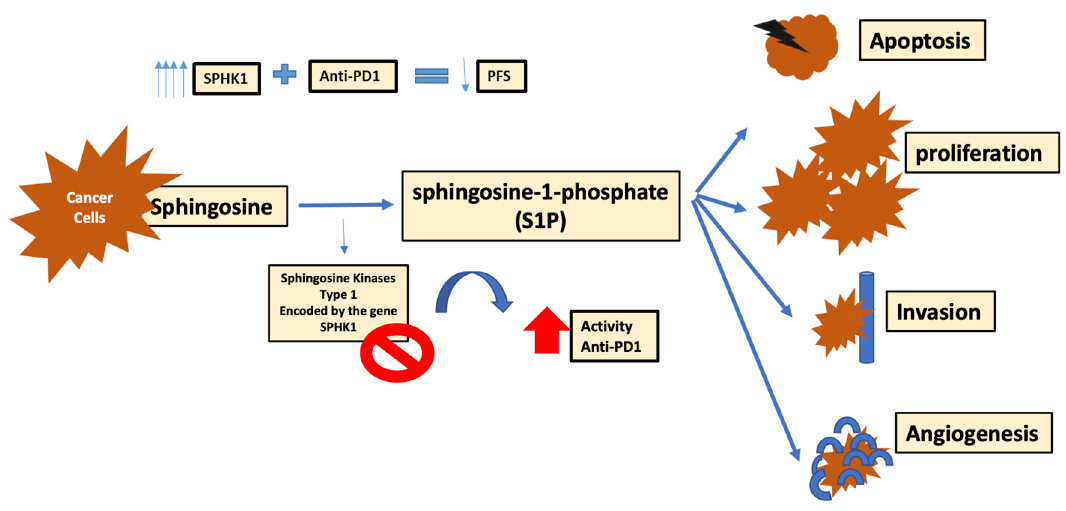
Figure 5. Sphingosine resistance mechanism PFS (progression free survival).